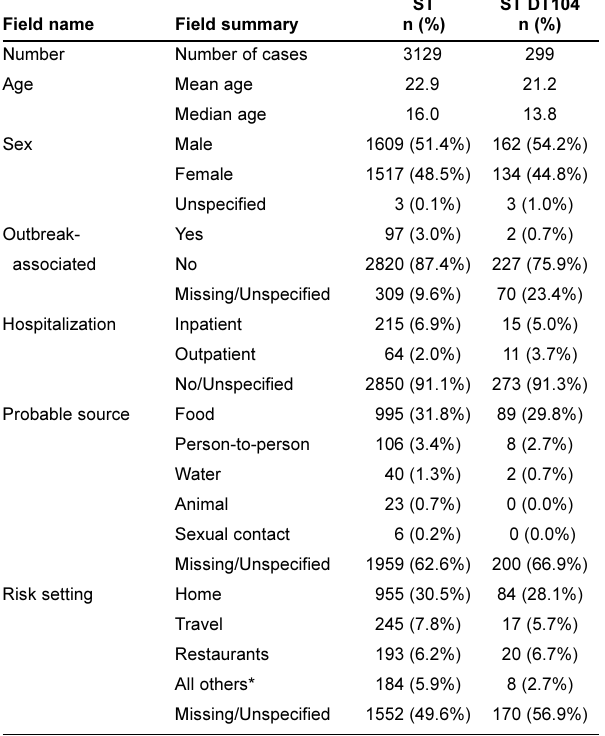
TABLE 3 Comparison of demographic characteristics, reported risk factors and hospitalization rates for cases of Salmonella serotype typhimurium (1990 to 1997) infections and ST definitive type 104 (DT104) infections (August 1997 to July 1998) in Ontario